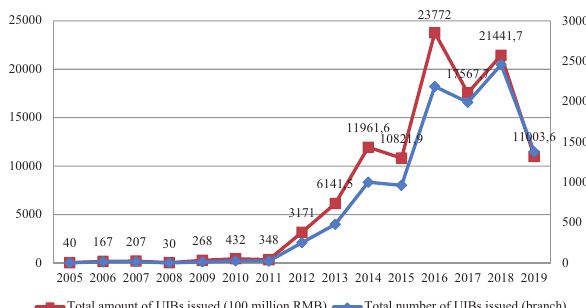
Figure 1. Amount of China’s Urban Investment Bonds